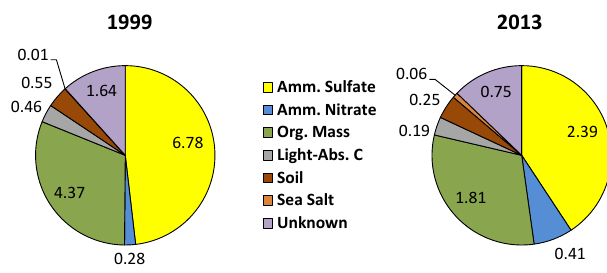
Figure 7. Comparison of IMPROVE PM 2 . 5 mass chemical distri- butions for 1999 and 2013 at Look Rock. “Light-Abs. C” denotes the EC component, “Soil” denotes particles of various oxides (e.g., iron oxide) associated with soils and “Unknown” represents mass whose composition is indeterminate (most likely some water along with mass associated with OC that is not included in the 1.8 adjust- ment factor applied by IMPROVE to OC to estimate OM). Num- bers associated with each pie section denotes the annual mean mass (µgm − 3 ) of that chemical constituent.